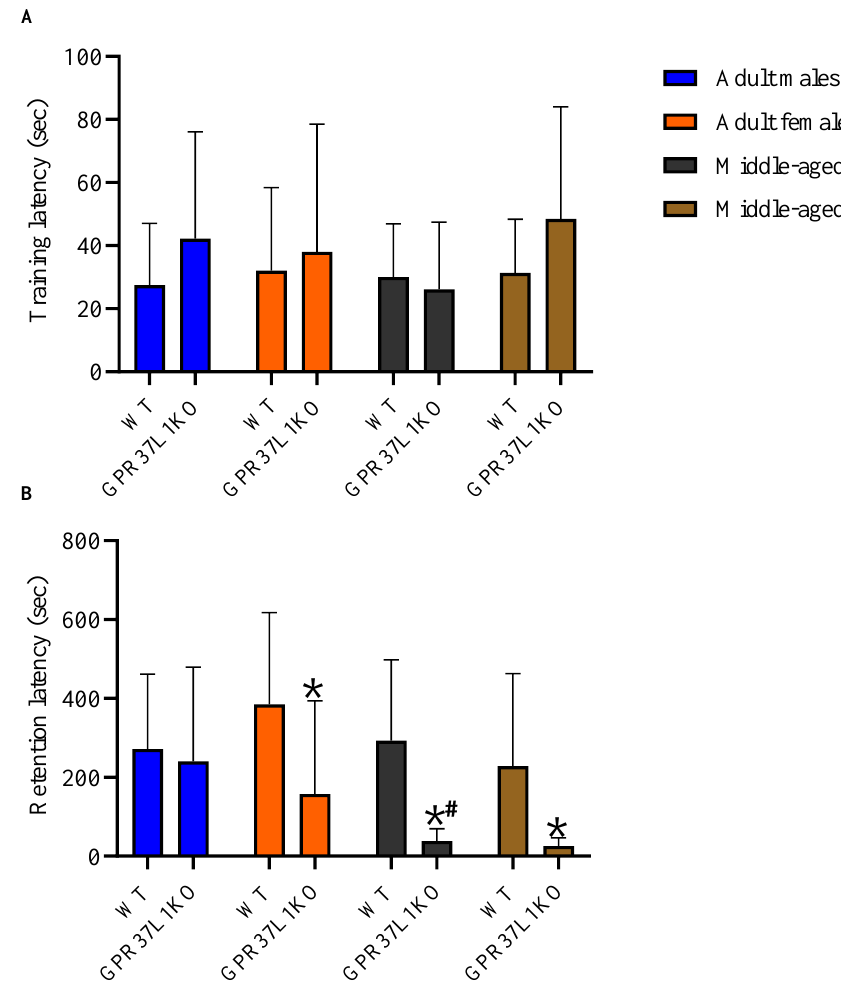
Figure 3. Effect on aversive memory in adult and middle-aged WT and GPR37L1KO males and females. Training latency ( A ) and retention latency ( B ). n /group: 7 to 12. All data represent mean